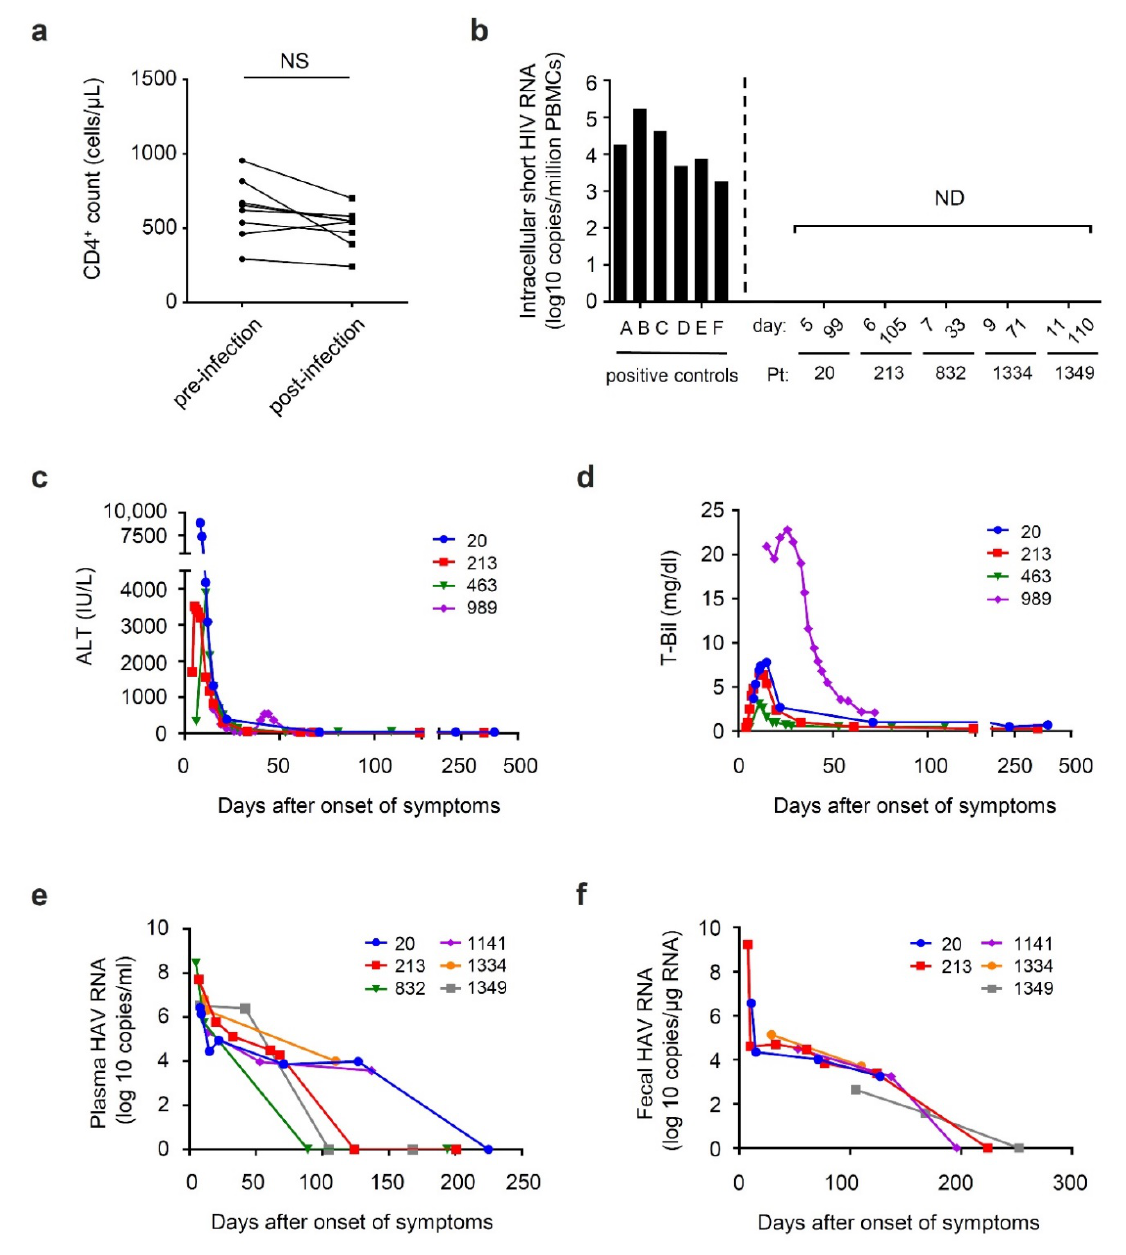
Figure 1. Changes in the levels of human immunodeficiency virus (HIV) in the blood and hepatitis A virus (HAV) excretion in the stool during the period from immediately after acute HAV infection to after healing. The day of clinical onset was set to day 1 on the horizontal axis; ( a ) CD4 count (cells/mL) of patients with HIV after HAV infection; ( b ) intracellular short HIV transcripts in peripheral blood mononuclear cells (PBMCs) (copies/million PBMCs). Patients A-F shown on the left were positive controls for the transcripts; ( c ) the levels of alanine aminotransferase (ALT) in plasma fractions of patients (U/mL); ( d ) the levels of total bilirubin (T-Bil) in plasma fraction of patients (mg/dL); ( e , f ) the levels of HAV-RNA in the plasma (copies/mL); ( e ) and the feces (copies/μg RNA) ( f ) of patients. NS: Not significant; ND: Not detected.